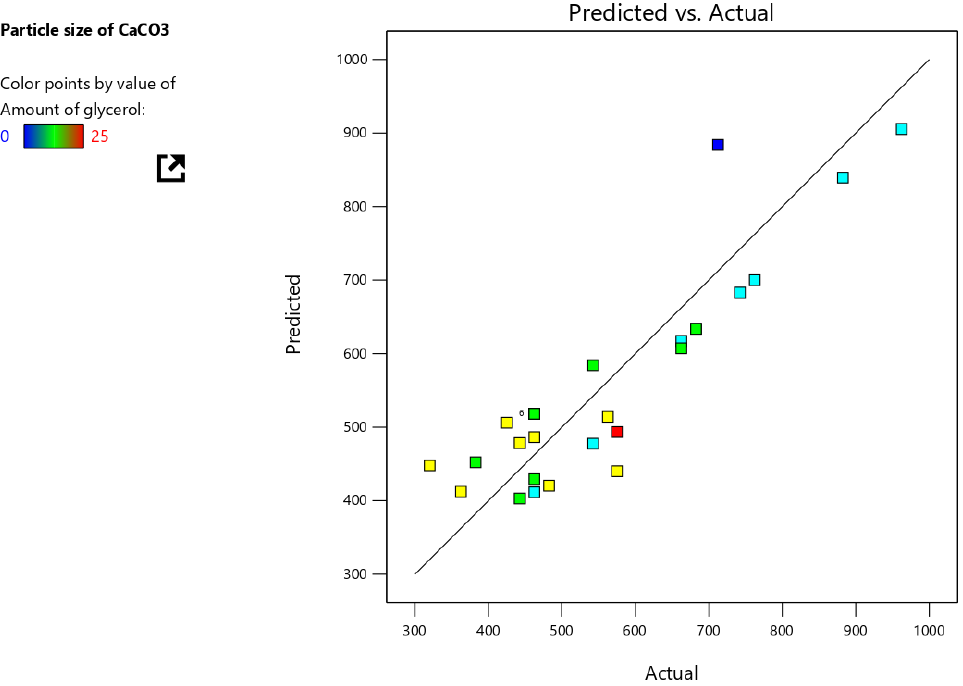
Processes 2022 , 10 , x FOR PEER REVIEW Figure 9. CaCO 3 particle size relationship between expected and experimental results.